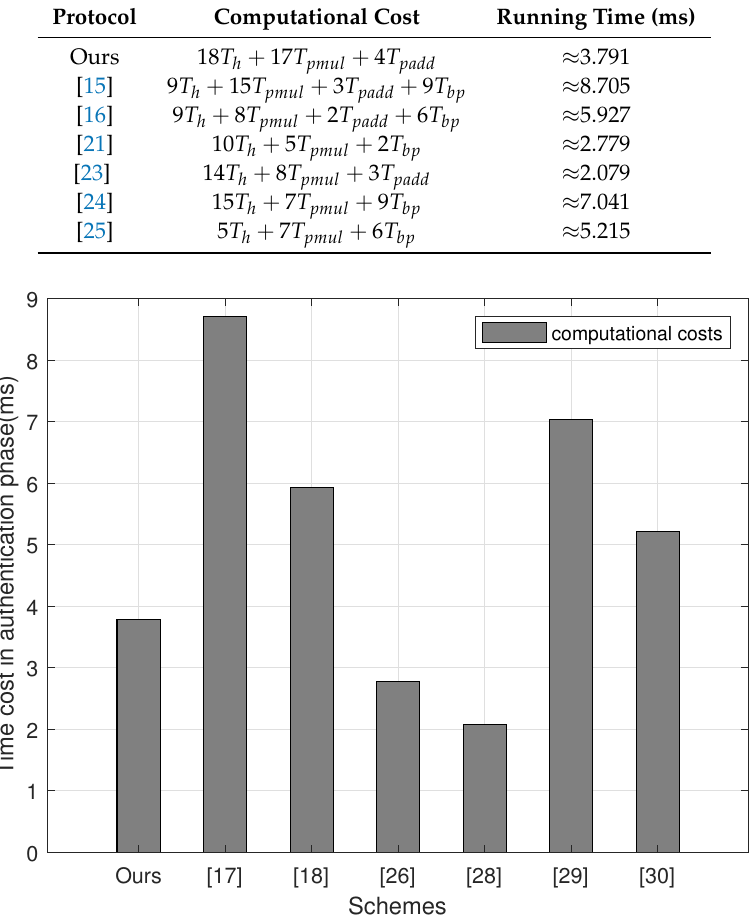
Table 3. Comparison of computational cost.